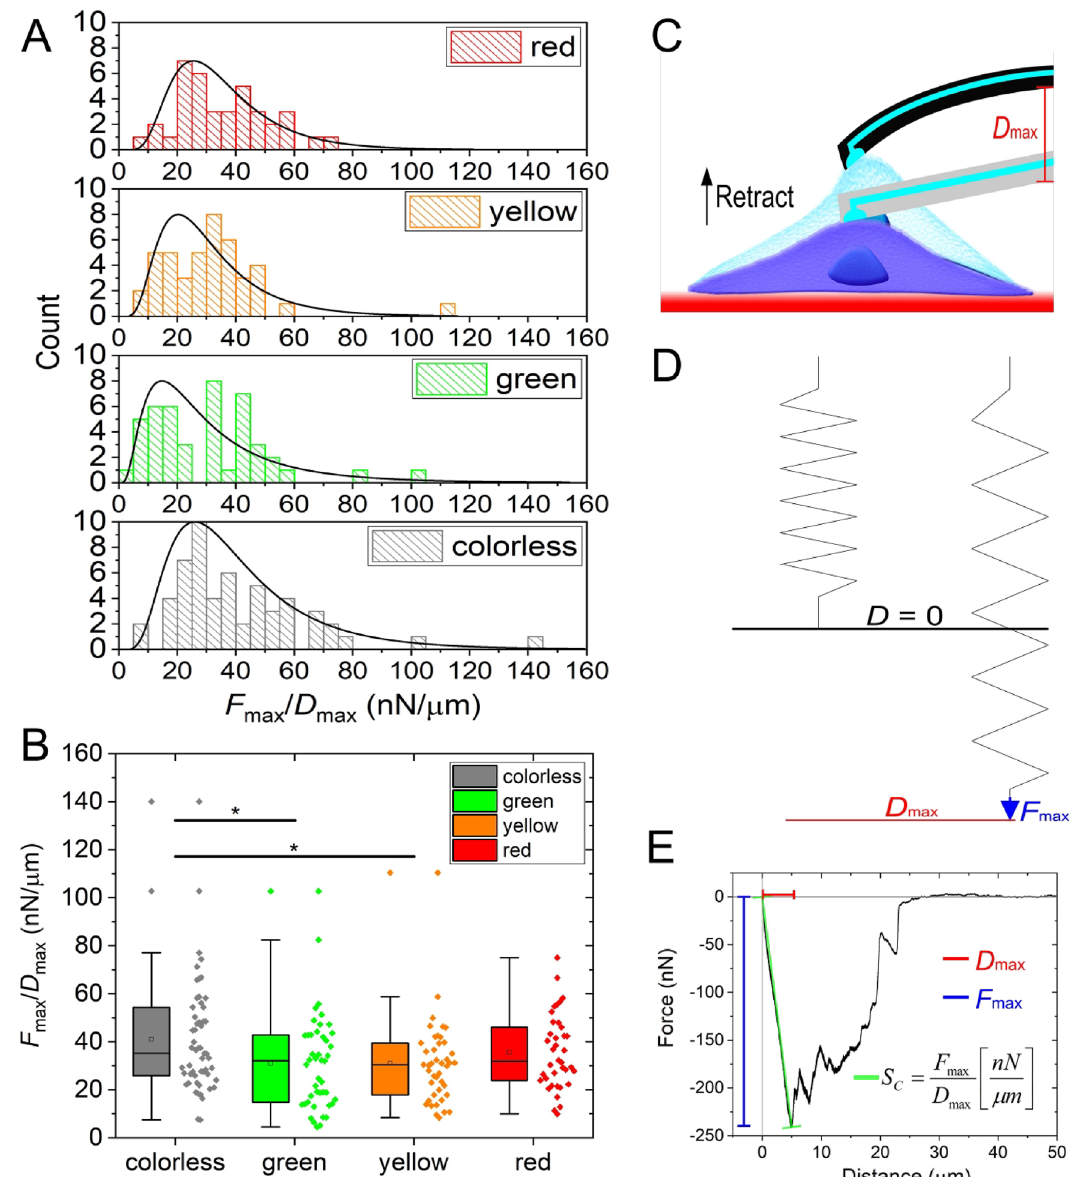
Figure 6. Spring coefficient ( S c ) characterizes the elasticity of the cell and the illustration of its physical meaning. S c produced lognormal distributions in all color phases (A) , and a significant difference between colorless, green, and yellow cells (B) . The elastic capability of the cell shows a deformation upon pulling it from the surface with the FluidFM cantilever. Note the drawing is not in scale. In reality, the bending of the cantilever is small compared to the elongation of the cell. ( C ), which can be interpreted as the pulling of spring with a specific amount of force. The longest elongation D max is reached when pulling the cell with the maximum force F max ( D ). Thus the fraction D max and F max yields S c , which is the linear slope connecting the maximal force– elongation with the zero level ( E